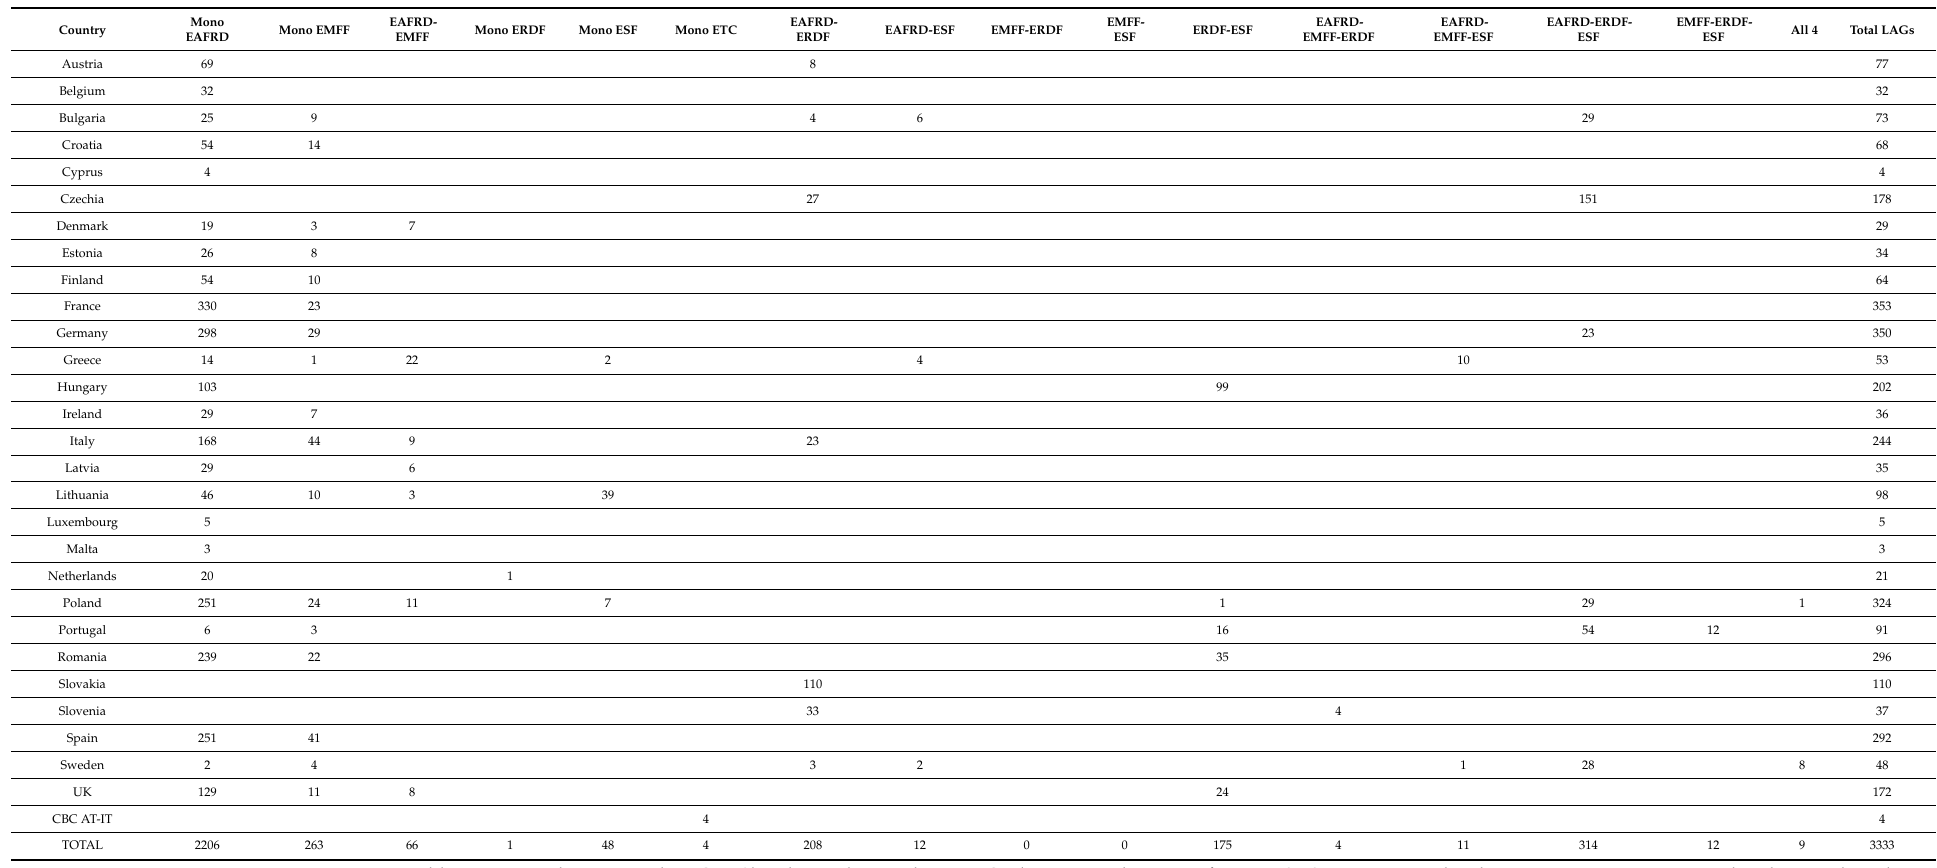
Table 2. Number of CLLD LAGs in the EU28 and their use of ESI